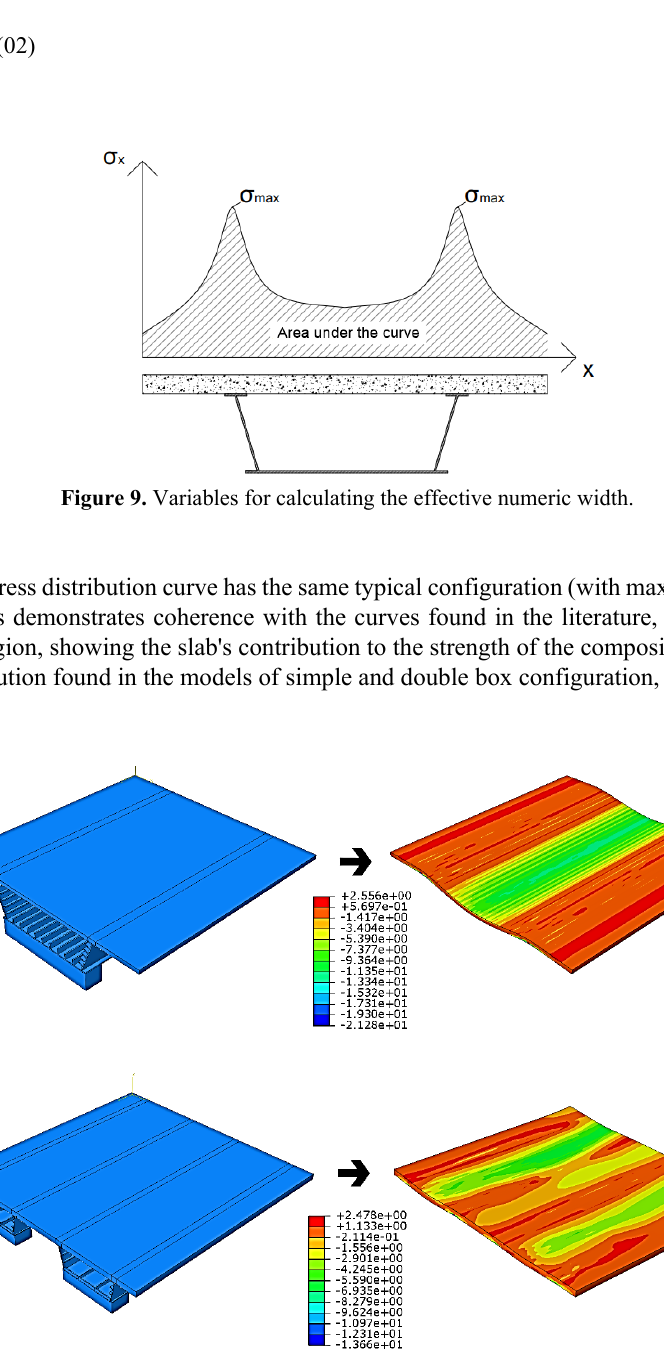
Figure 10. Stress distribution typical of models in single and double box configurations. [N/mm 2